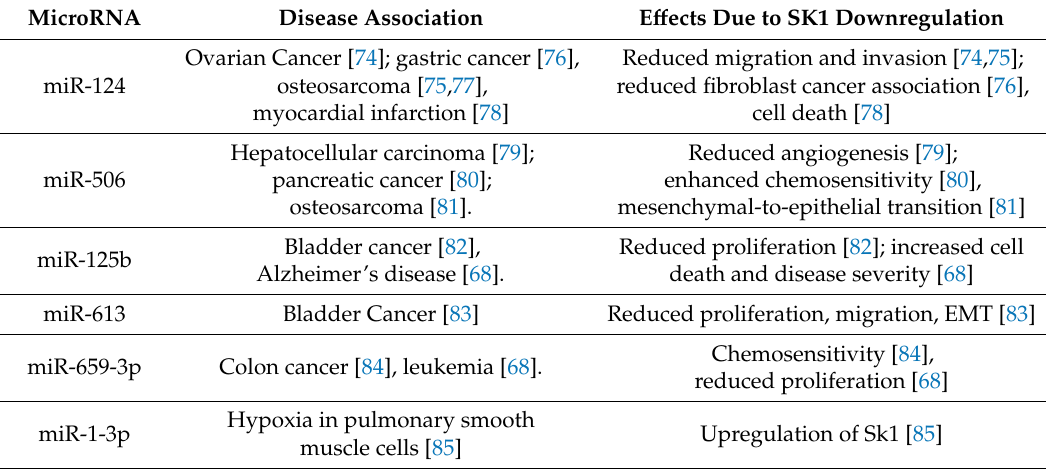
Table 1. microRNAs Known to Downregulate